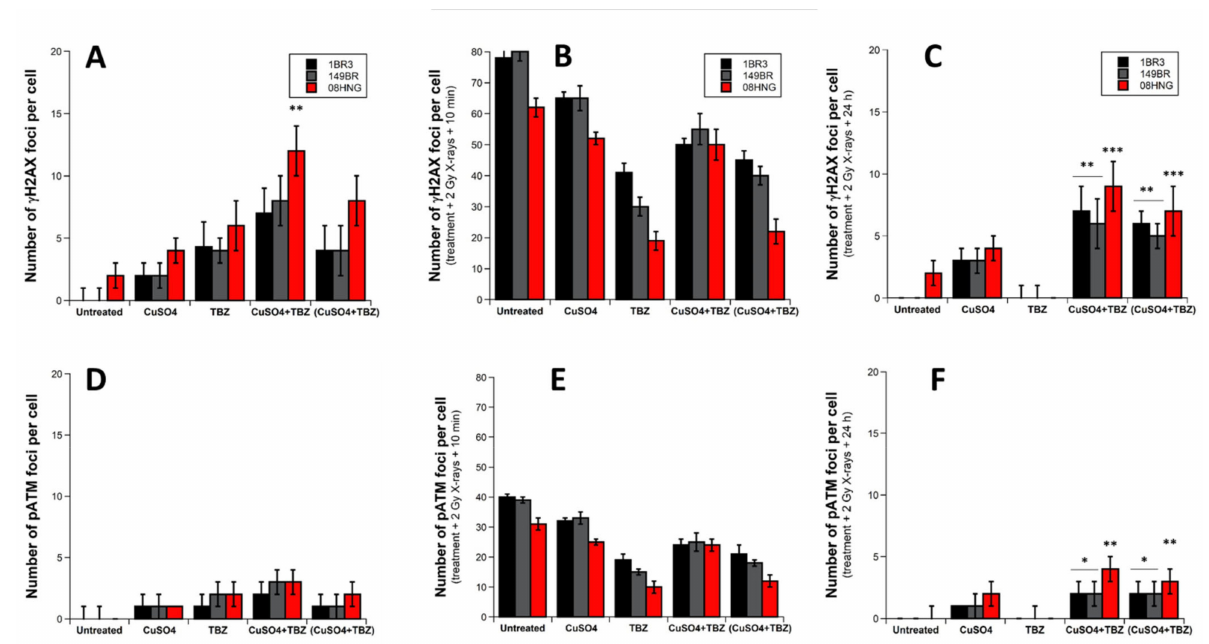
Figure 7. γ H2AX and pATM foci from fibroblasts exposed to CuSO 4 and/or TBZ. Indicated cells were exposed to 24 h incubation with the indicated metal, pesticide, CuSO 4 +TBZ or 99% purified (CuSO 4 +TBZ) complexes solutions, then irradiated at two Gy X-rays and incubated up to 24 h for repair. “Untreated” mention means that neither pesticide nor metal were applied to cells before irradiation. Number of γ H2AX and pATM foci per cell assessed before irradiation ( A , D ), at 10 min post-irradiation ( B , E ) and at 24 h post-irradiation ( C , F ), respectively. Each plot represents the mean ± standard error (SEM) of 3 replicates. One, two, or three asterisks represent significant differences from TBZ data with p < 0.05, p < 0.01, and p < 0.001,